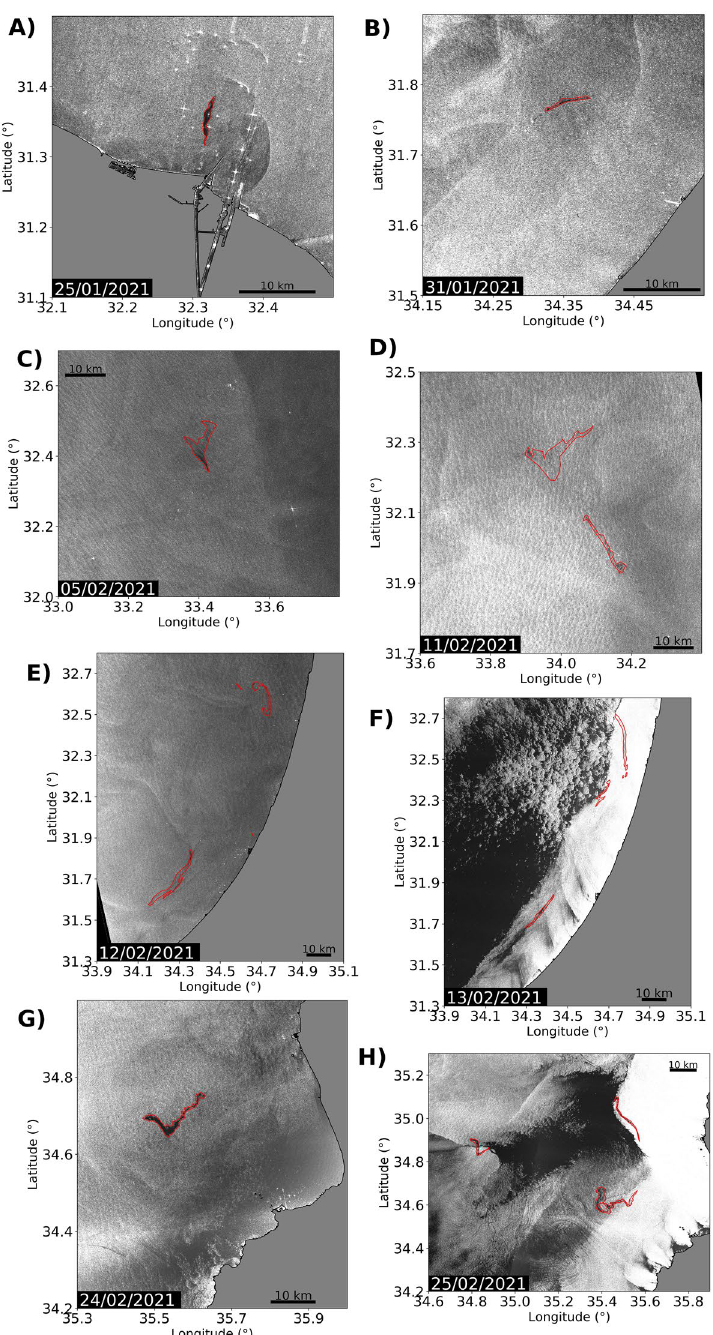
Figure 2. Satellite radar images. ( a ) Sentinel 1A on the 25th January 2021; ( b ) Sentinel 1A on the 31st January 2021; ( c ) Sentinel 1A on the 5th February 2021; ( d ) Sentinel 1B on the 11th February 2021; ( e ) Sentinel 1A on the 12th February 2021; ( f ) Sentinel 1A on the 13th February 2021; ( g ) Sentinel 1A on the 24th February 2021; ( h ) Sentinel 1A on the 25th February 2021. The figure has been created using python 3.8.10 and matplotlib module 3.1.2 (https:// www. python. org/ downl oads/ relea se/ python- 3810/). Coastlines have been obtained from https:// osmda ta. opens treet map. de/ data/ land- polyg ons. html. The satellite observations vector representations have been created using QGIS software 3.10 version (https:// qgis. org/) and the SAR processed